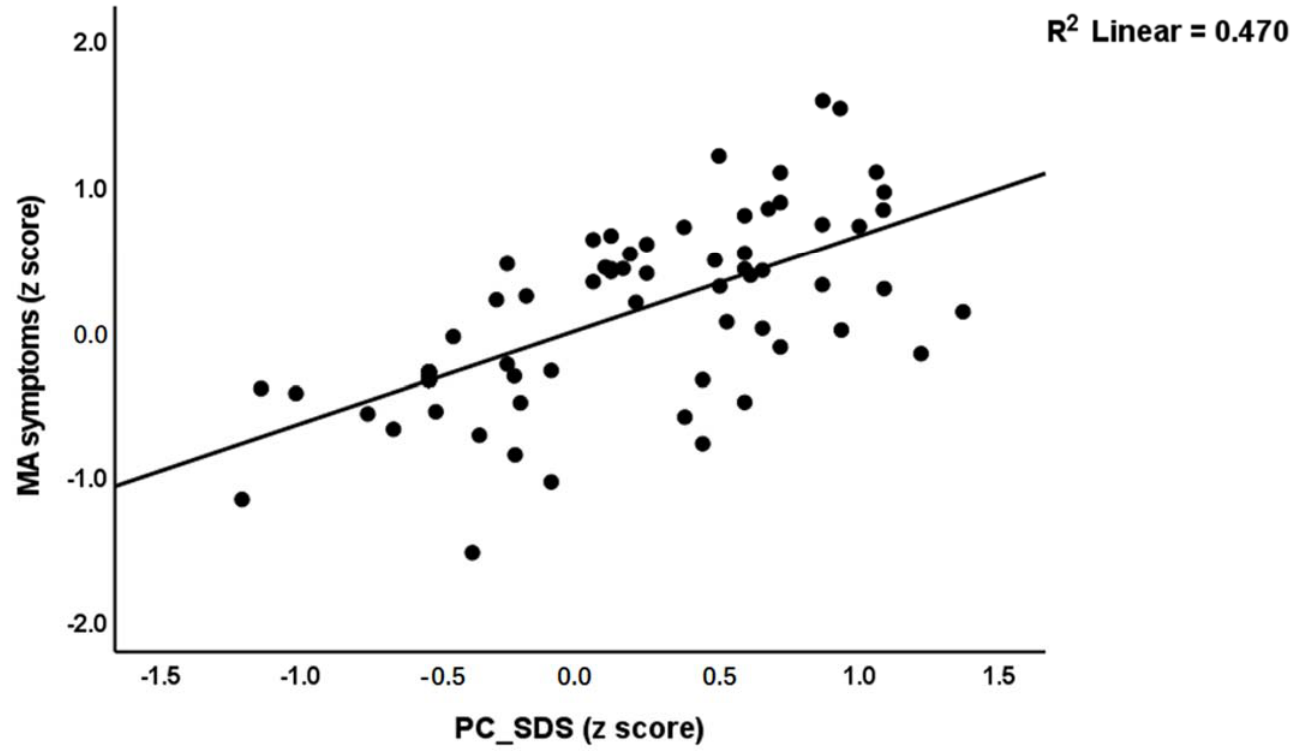
Figure 4. Partial regression plot of the overall severity of methamphetamine (MA)-induced psychotic symptoms (MA symptoms) on MA dependence (PC-SDS).